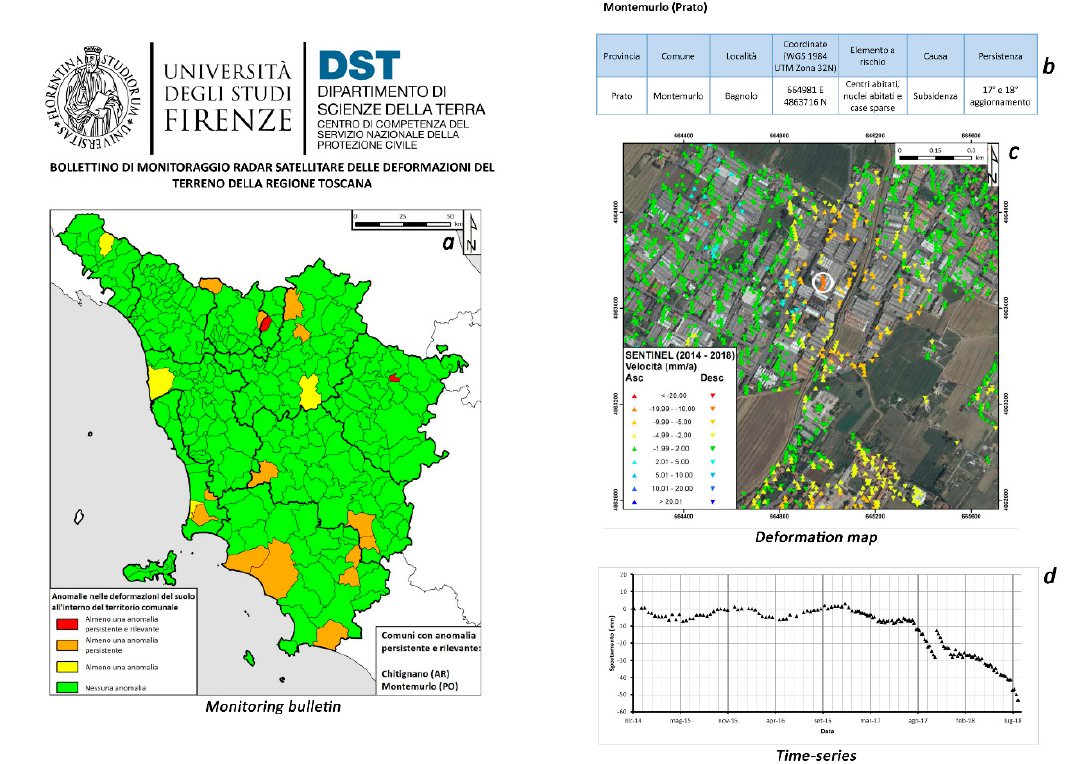
Figure 4. Structure of the monitoring bulletin. Front page with municipality classification ( a ), information about the AP ( b ), deformation map of the area with relevant and persistent APs ( c ) and time-series ( d ).